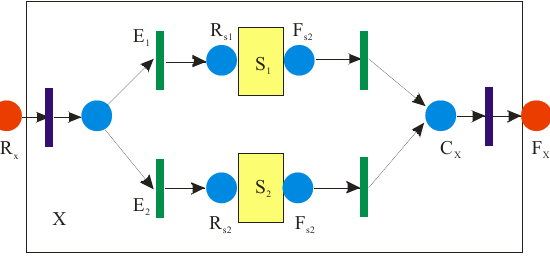
Fig.4. The service net for BPEL switch pattern Here, a switch activity contains an ordered set of services with associated conditions, and executes the corresponding contained activity for which the associated condition is satisfied. In Fig.4, Z conditions for the branches with Web service S respectively. ⑥ , StSm →→ represents BPEL's pick pattern pick 21 either waits on a message event or a timing event. Fig.5 shows how this can be mapped onto a service net.